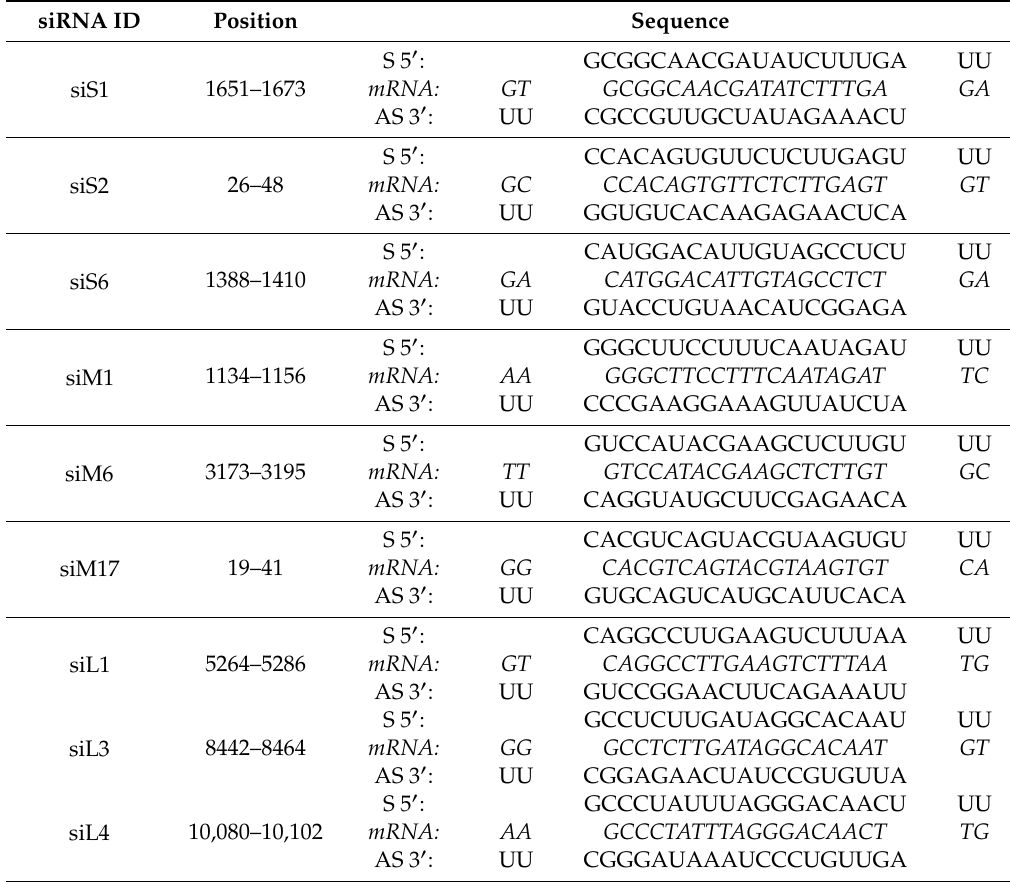
Table 2. List of designed